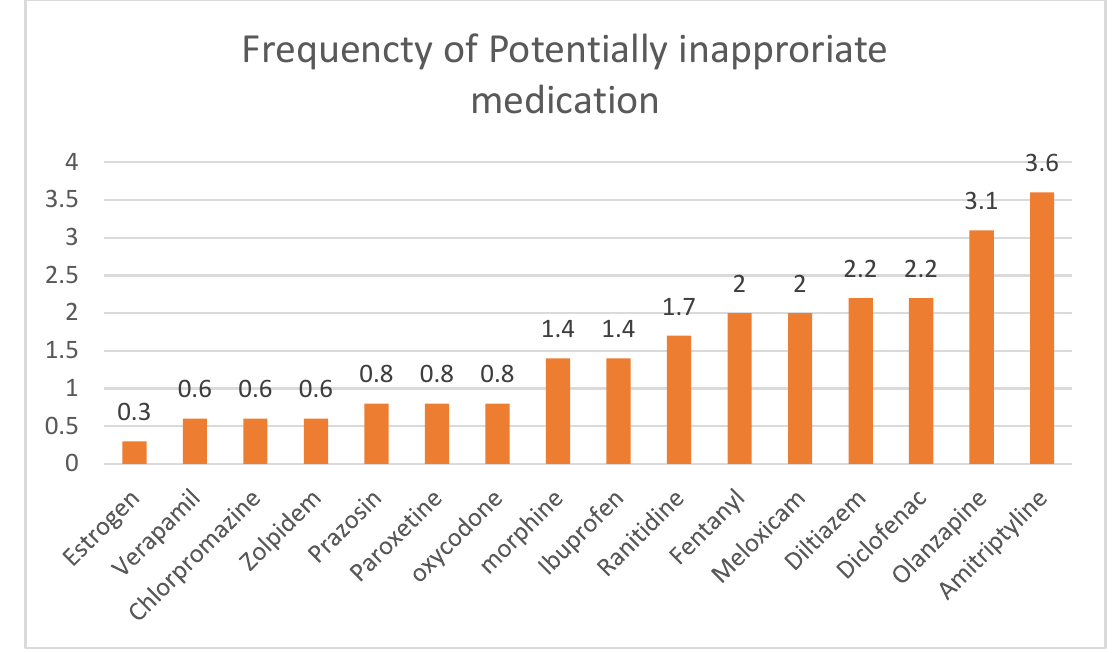
Figure 1. Percentage of PIM prescribed to study participants based on the Beers criteria.